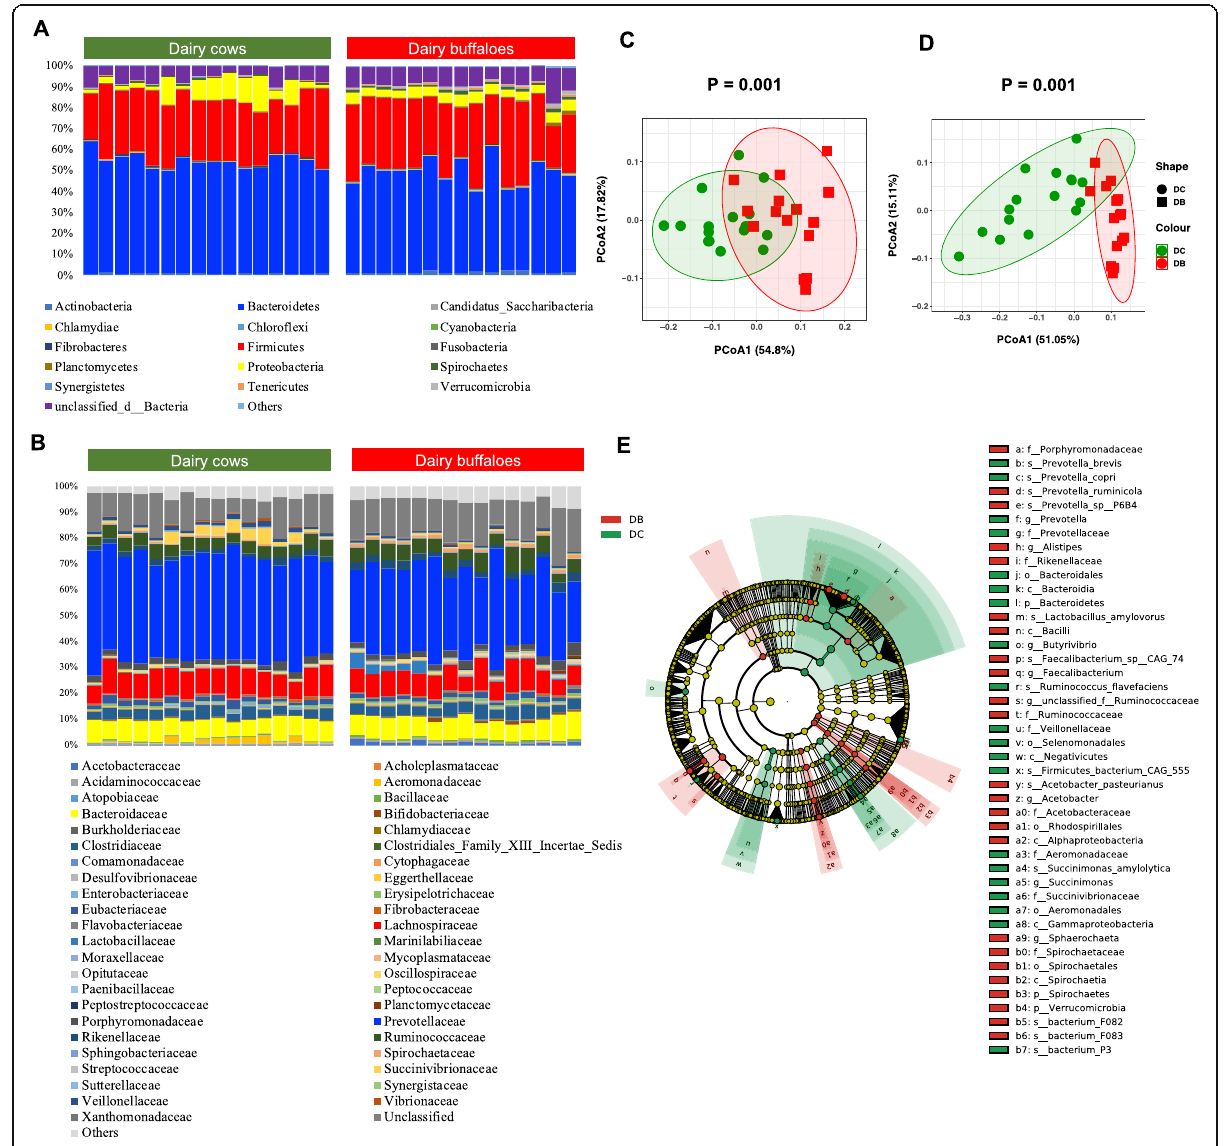
Fig. 1 Rumen bacterial compositional profiles of dairy cows and dairy buffaloes. A Relative abundance of major bacteria phyla (relative abundance > 0.1% in more than 50% animals) for all individuals. B Relative abundance of major bacteria families (relative abundance > 0.1% in more than 50% animals) for all individuals. C Principal coordinate analysis (PCoA) of bacteria genera based on Bray-Curtis distance. D PCoA of bacteria species based on Bray-Curtis distance. E Cladogram of significantly different taxa identified in the rumen microbiome data sets of dairy cows and dairy buffaloes based on the cut-off of LDA > 3.5 and P < 0.01. Clades significantly enriched in each cohort are highlighted by the colors shown in the legend. DB: dairy buffalo; SDF: significantly different feature; LDA: linear discriminant